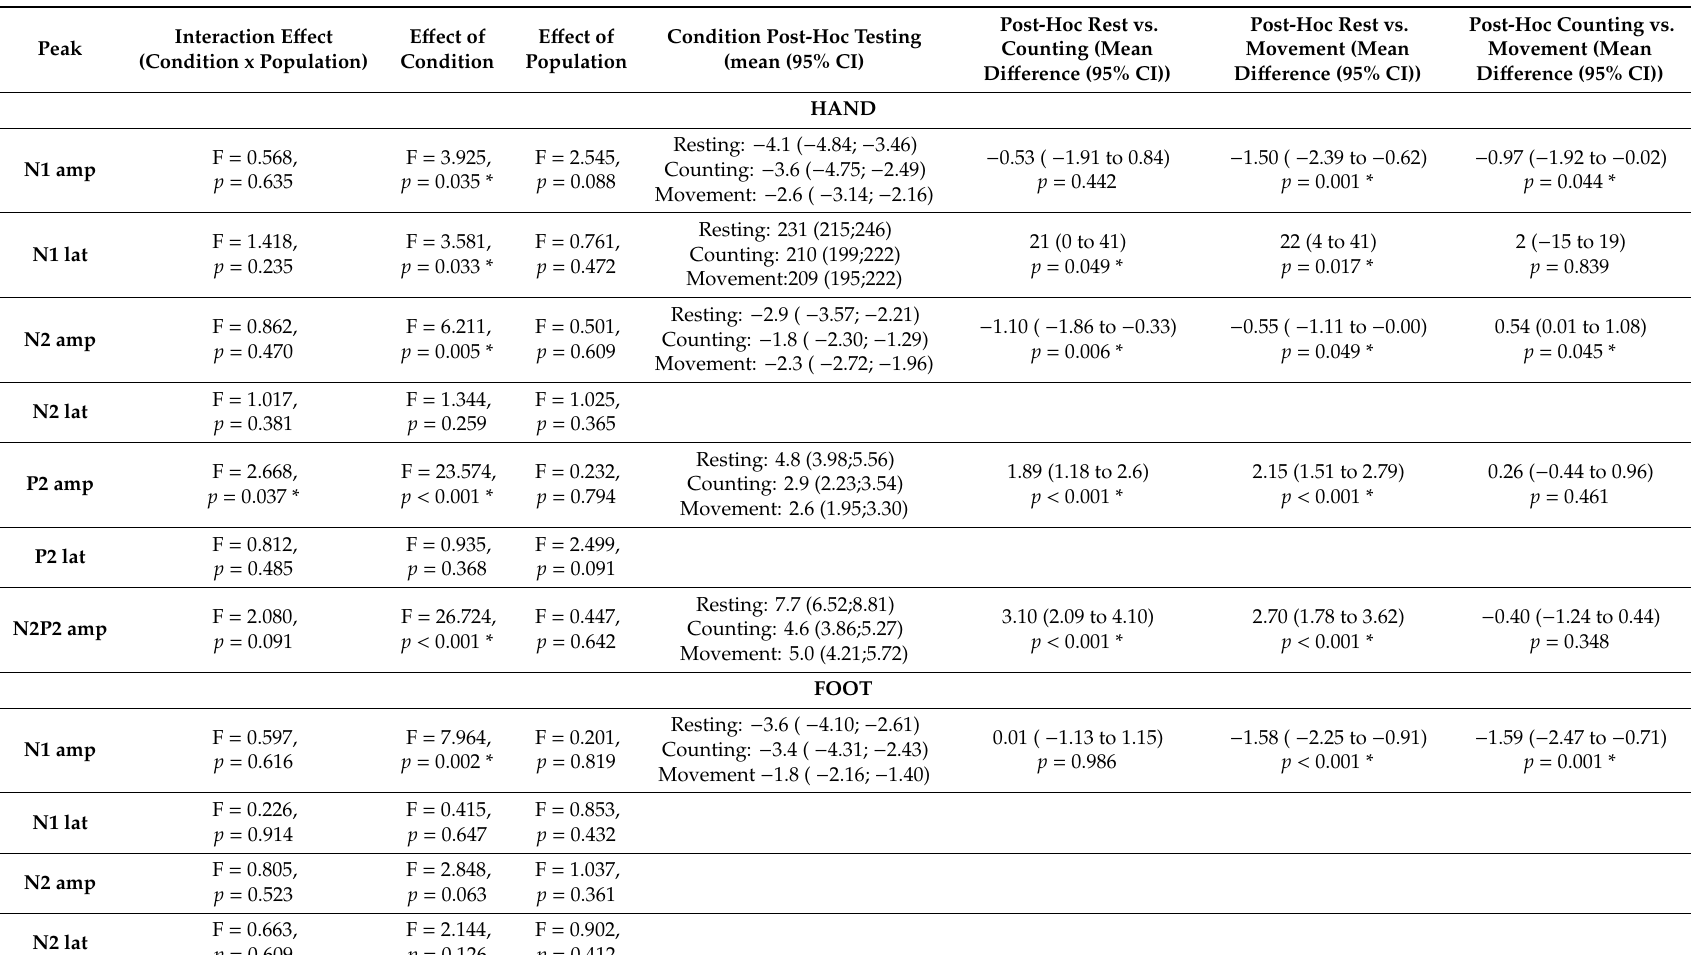
Table 3. Two-factor mixed design ANOVAs for LEP latencies and amplitudes, separated by type of condition, location and population for nociceptive laser stimulation.